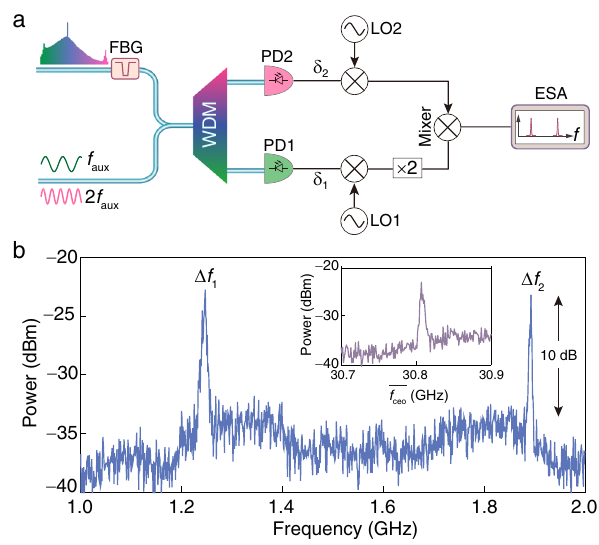
Fig. 5 f – 2 f heterodyne measurement. a Schematic diagram for assessing the f ceo . The symbol “ ×2 ” indicates a radio frequency doubler. The experimental details are introduced in Supplementary Fig. 6c. b Free- running f – 2 f beatnotes after the down-conversion process, suggesting a signal-to-noise ratio of 10 dB at a resolution bandwidth of 1 MHz. The local oscillator frequencies f LO1 and f LO2 are chosen to be 11.8 and 9.1